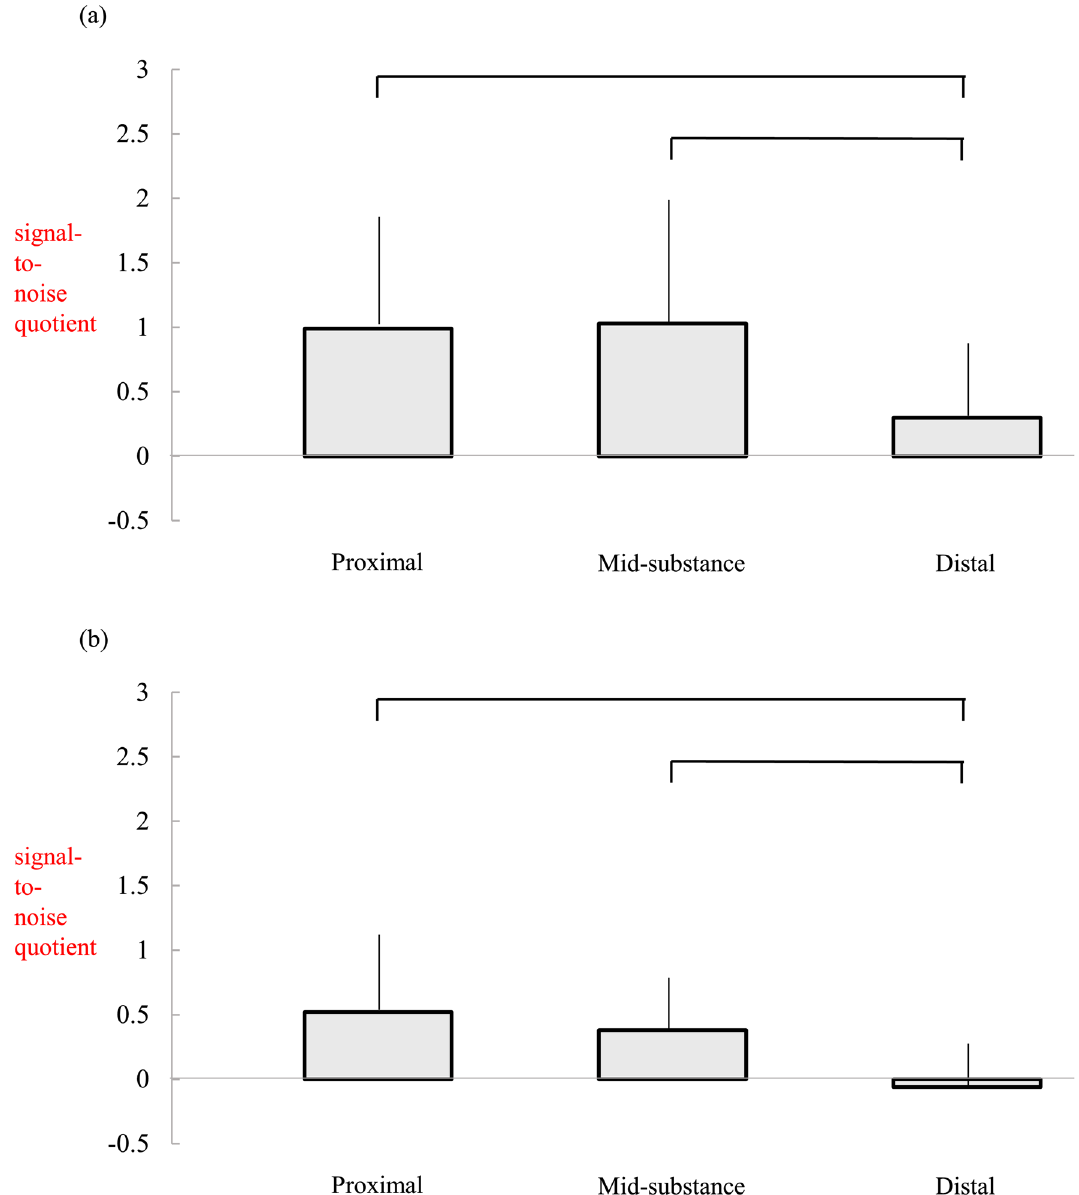
Figure 3. Comparison of the signal-to-noise quotients of the different reconstructed anterior cruciate ligament sites in the immature group 2 ( a ) and control group 2 ( b ). The SNQ of the distal site is significantly lower than that of the proximal and mid-substance sites within each group. SNQ signal-to-noise